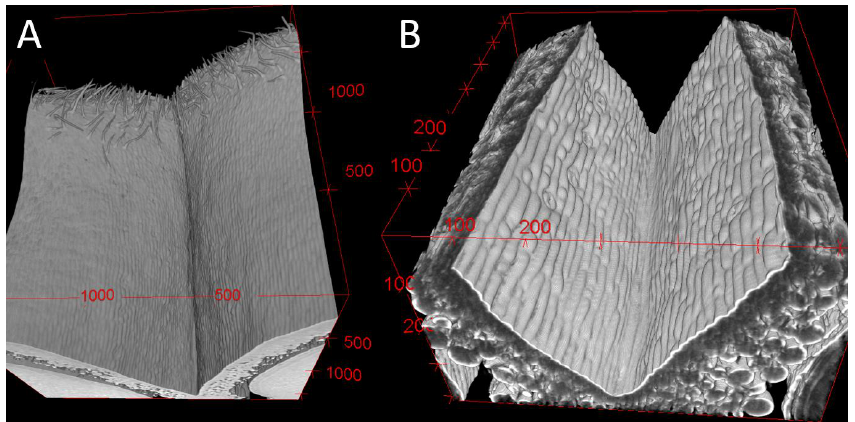
Figure 8. 3D visualization of the epidermis of grains at 200 °DAA using a low-resolution ( A ) or high- resolution ( B ) scan. Both images correspond to a crop of the original 3D stack to better visualize the epidermis cells. Red digits and ticks correspond to spatial calibration in microns.